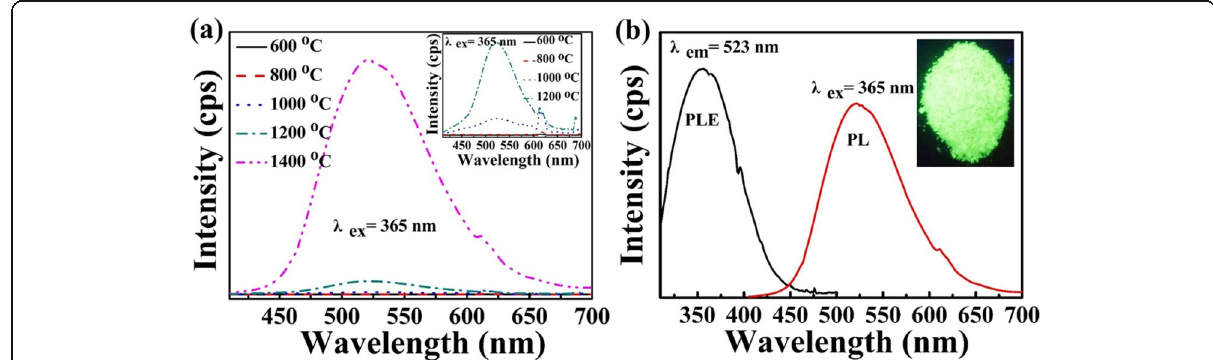
Fig. 3 a PL emission spectra for zeolite-3A: 1.3 wt% Eu phosphors sintered at different temperatures, respectively. The inset shows the magnifying spectra. b photoluminescence excitation (PLE) and photoluminescence (PL) emission spectra for zeolite-3A: 1.3 wt% Eu phosphors sintered at 1400 °C for 3 h. The inset is the photograph of the sample with the illuminaton of a 365-nm UV